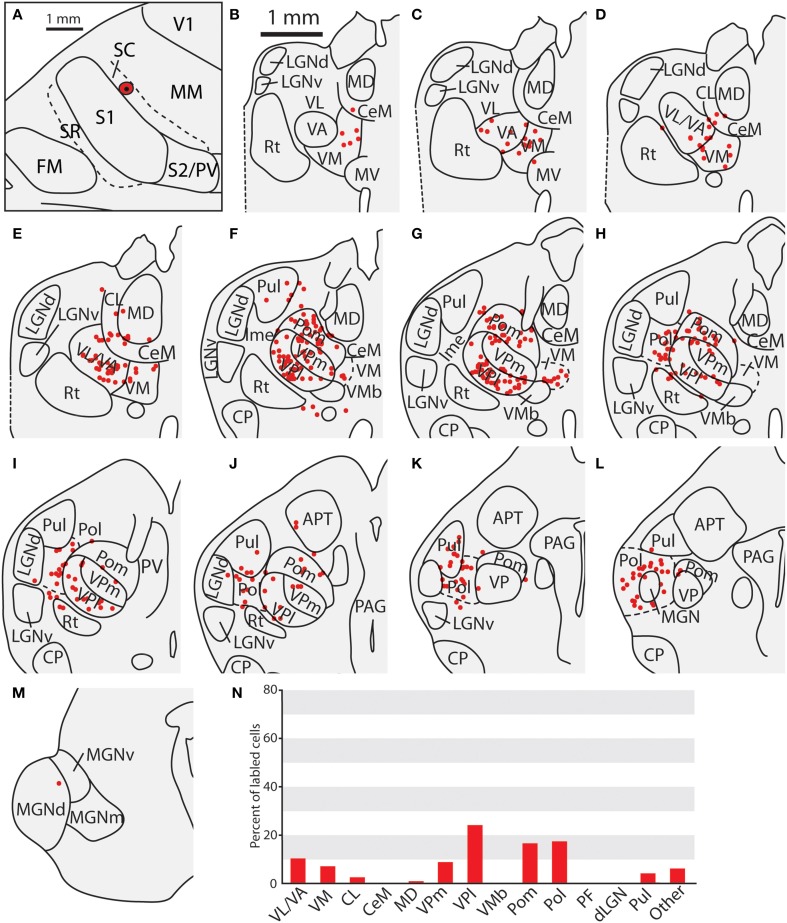
Thalamic projections to area SC in case 13-73. (A) Location of cortical injection sight of FR into SC. (B–E) Labeled cells can be seen throughout VL/VA and VM. (F–J) Additional numerous labeled cells can be seen throughout VPl and VPm, as well as Pom. (K,L) As with Figure 8, labeled cells can be seen throughout Pol, sometimes extending laterally into LGNd and Pul, along with labeled cells at the caudal-most extent Pol as the Medial Geniculate complex begins to emerge. (M) A single cell was observed in the medial geniculate complex. (N) Percent of labeled thalamic neurons projecting to SC. Conventions as in previous figures.